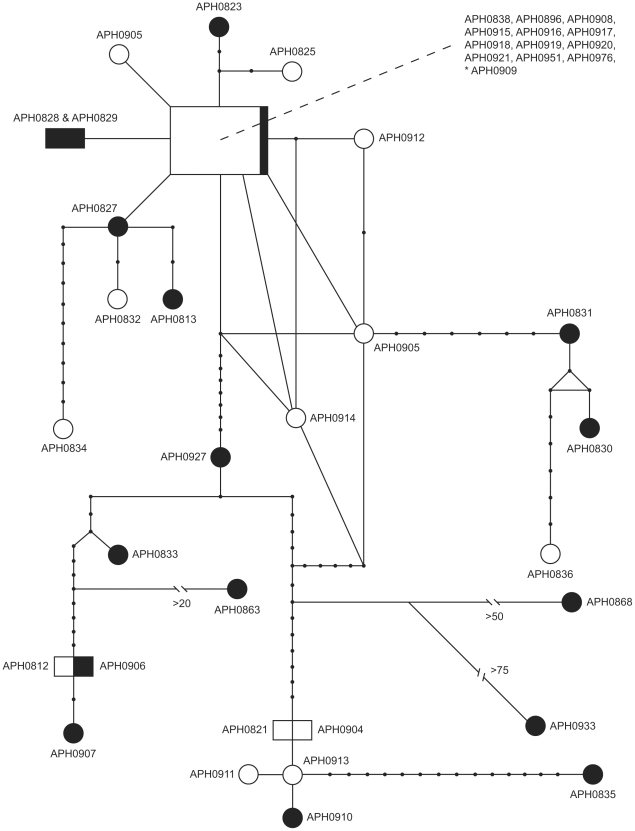

Aphonopelma hentzi haplotype network.Specimens sampled from across the A. hentzi distribution are represented in a haplotype network. Black objects represent haplotypes designated as “southern” haplotypes (south of the Colorado River) and white objects represent “northern” haplotypes (north of the Colorado River). The * denotes the APH0909 haplotype, the only “southern” haplotype represented in the most commonly shared haplotype box (proportionally separated between “northern” and “southern” haplotypes).